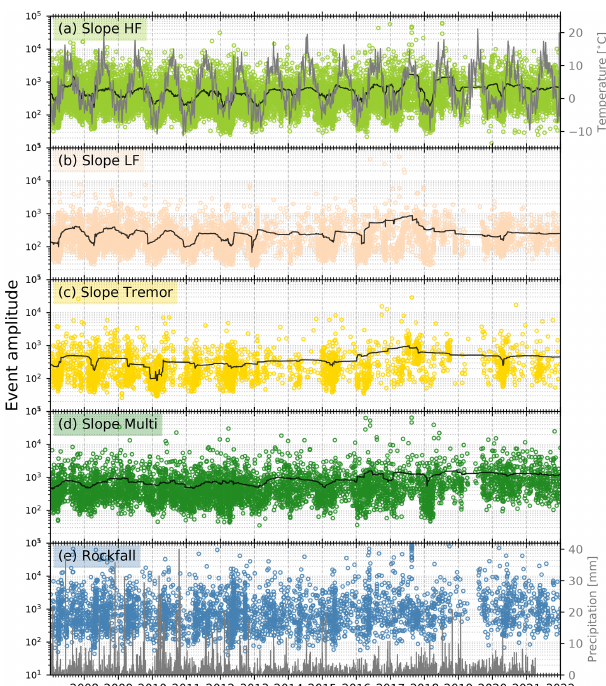
Figure 9. Amplitudes of events occurring on the slope over time (thin black: smoothing over 7d). Temperature smoothed with a 7d sliding window is added to (a) . Precipitation is supplemented in (e) .